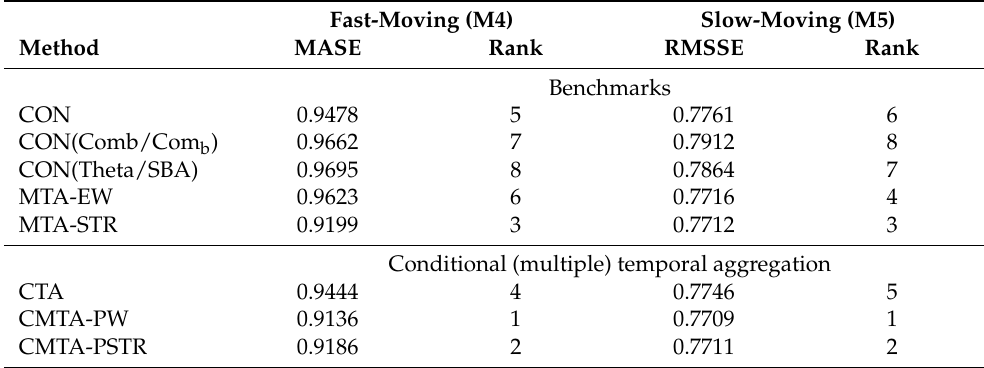
Table 3. Forecasting performance of the proposed method in the M4 (fast-moving data) and M5 (slow-moving data) series. MASE and RMSSE are used to measure accuracy in each set, respectively. The accuracy of the examined benchmarks is also reported to enable